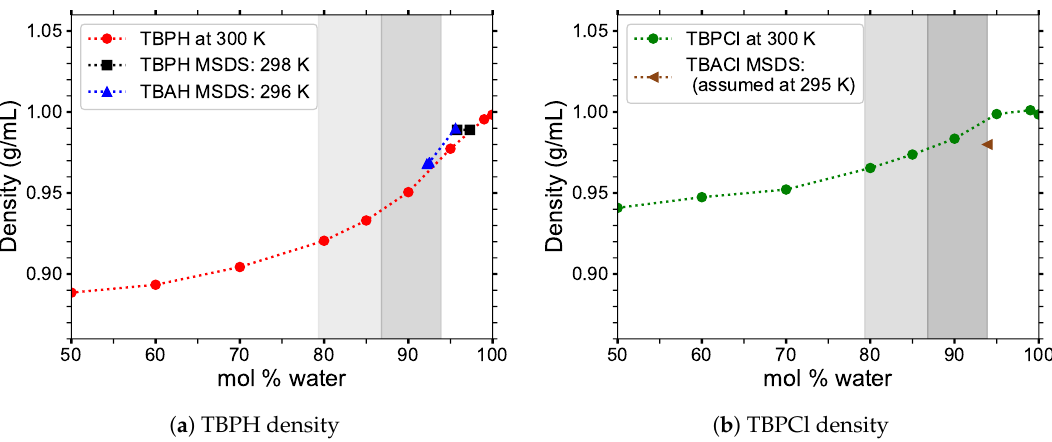
Figure 3. Simulated densities as a function of water concentration for p = 1atm and T = 300K, are plotted against material safety data sheet (MSDS) values: ( a ) TBPH density compared to MSDS values for TBPH at 60wt% water (95.8mol% water) [37,38], TBAH at 45wt% water (92.2mol% water) [39], and 60wt% water (95.6mol% water) [40]; ( b ) TBPCl density compared to the MSDS value for tetrabutylammonium chloride (TBACl) at 50wt% water (93.9mol% water)